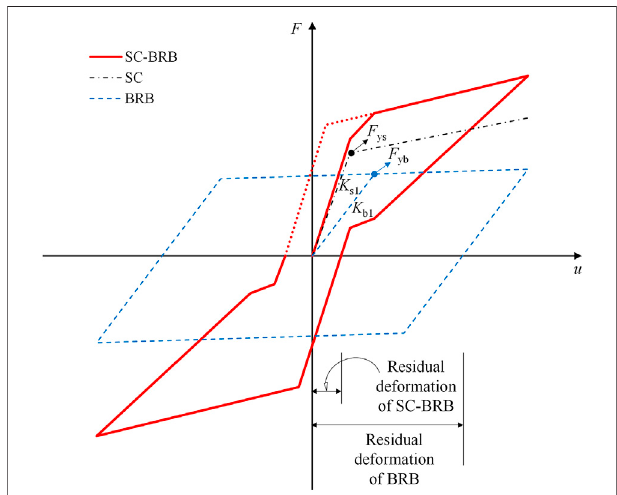
FIGURE 9 | Comparison of hysteretic curves of SC-BRB and BRB.